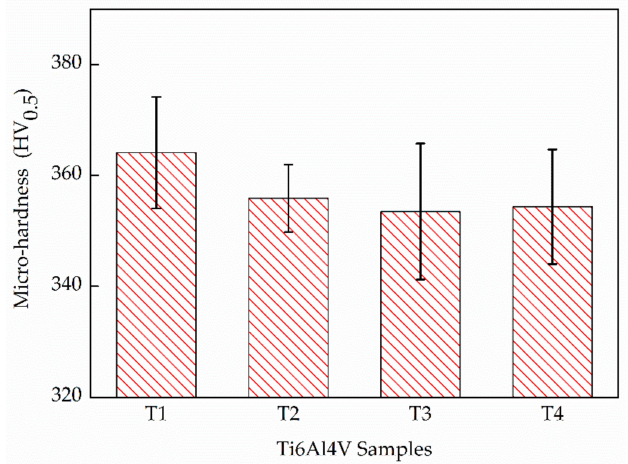
Figure 14. The micro-hardness (HV 0.5 ) of LMD Ti6Al4V samples.